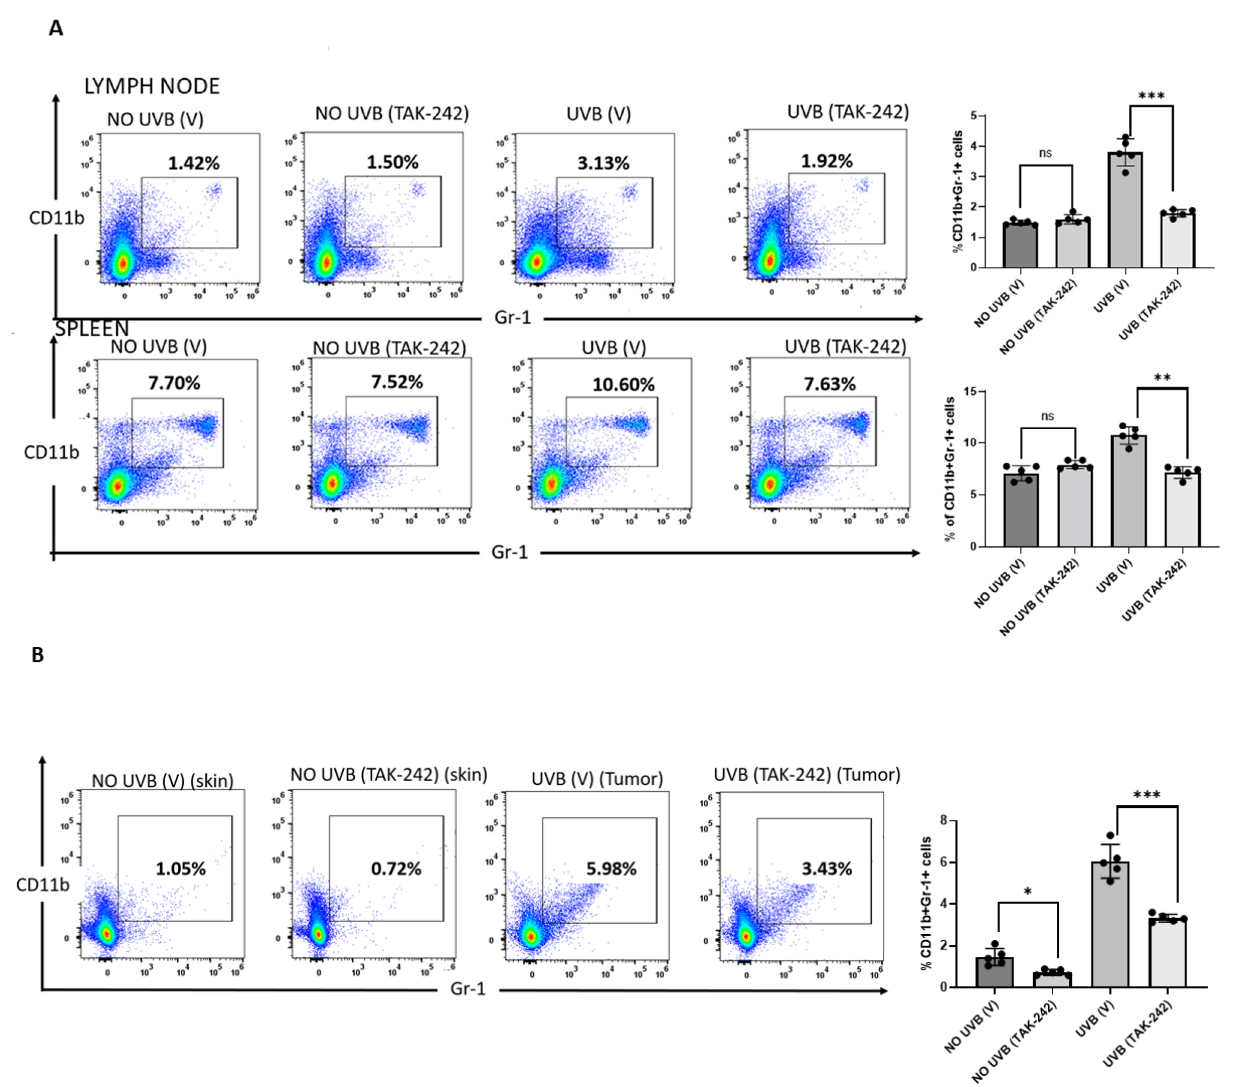
Figure 6. TAK-242 prevented the generation of CD11b+Gr1+ myeloid cells. SKH-1 mice were subjected to photocarcino- genesis experiment as mentioned in the Methods section. Mice were sacrificed at 30 weeks, and single cell suspensions of cells were prepared from the spleen and lymph nodes. Anti-CD11b and anti-Gr1 antibodies were used to stain the cells. The number of CD11b+Gr1+ cells, was analyzed by flow cytometry. There were significantly fewer Gr1+CD11b+ myeloid cells (** p < 0.01) in the spleens, ( A ) lymph nodes and ( B ) tumor of TAK-242 treated mice than vehicle-treated mice. The histograms depict the mean ± SD of cell number per group. Mice not exposed to UVB radiation were used as controls. Experiments were conducted in 5 mice in each group. (* p < 0.05, *** p < 0.001 and ns, not significant).